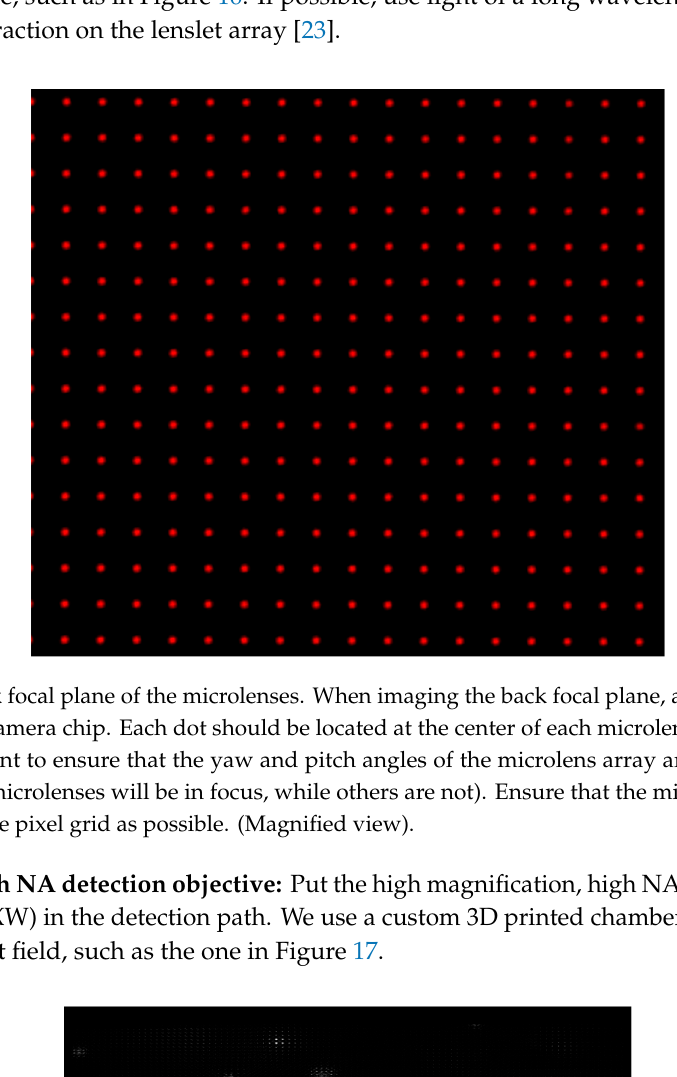
Figure 3. Beam expansion. Adjust the distance between the two lenses to guarantee that a collimated beam is achieved. Adjust their lateral positions so that the beam is not deviated.